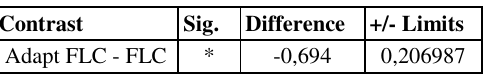
All the F-ratios are based on the residual mean square error